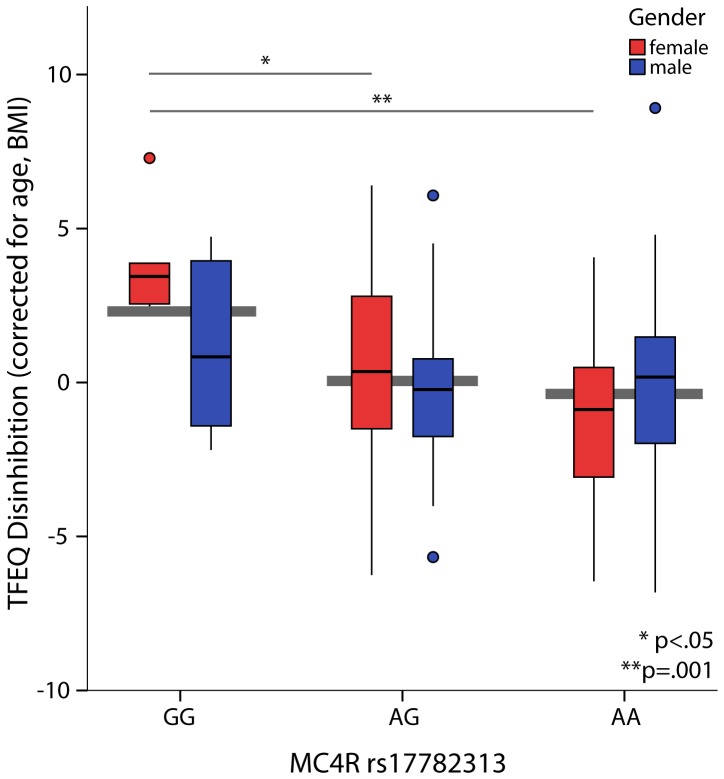
Sex-specific effect of rs17782313 near MC4R on ‘disinhibition’ scores (interaction F2,177 = 4.7, p = .01).Female homozygous carriers of the minor allele (CC) had significantly higher scores than both female heterozygous subjects (AC; difference in means 3.42, standard error 1.25, p = .024) and female subjects carrying no minor allele (AA; difference in means 4.93, standard error 1.22, p<.001). No significant difference was found for men (F2,107<1.5).